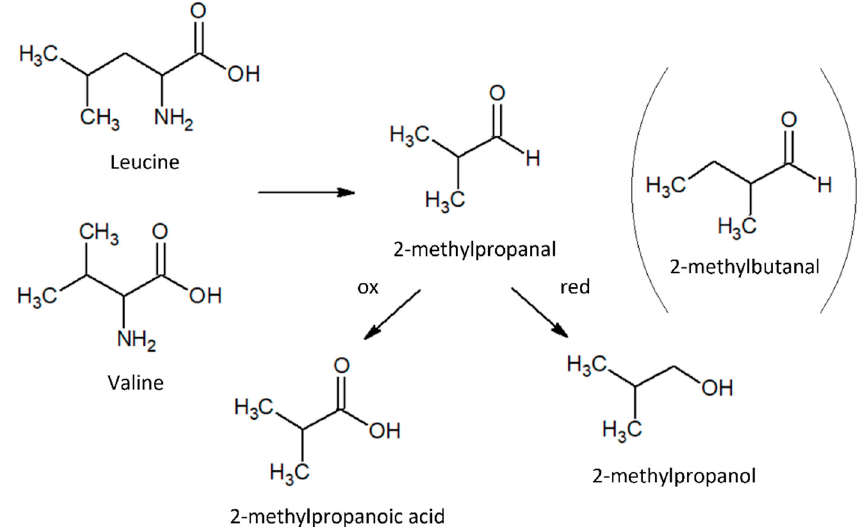
Figure 5. Scheme of 2-methylpropanal biosynthetic pathway and red-ox molecular